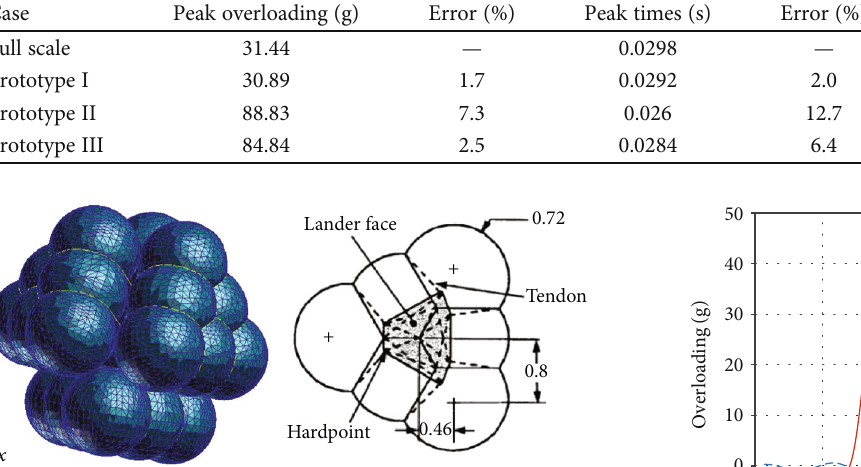
Figure 4: Model of the Mars Path fi nder airbags.